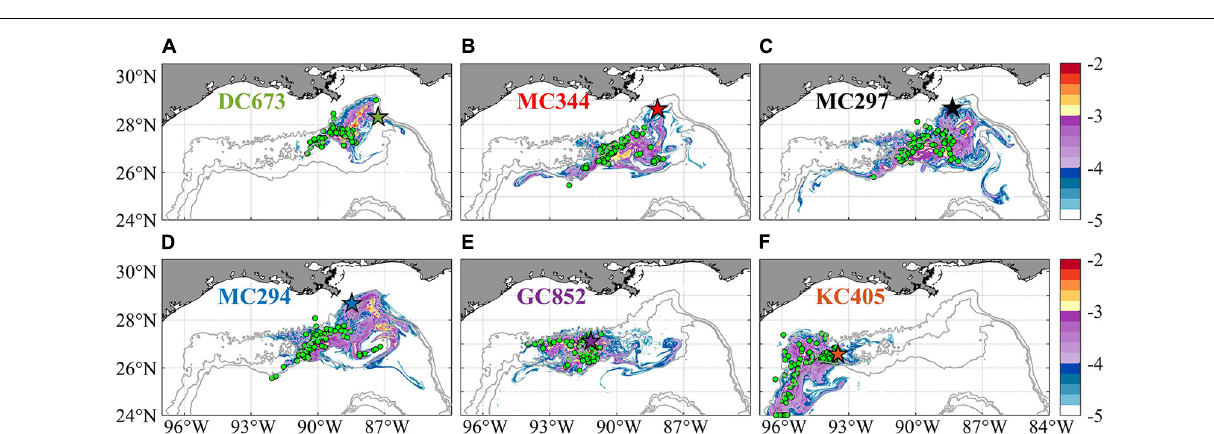
FIGURE 11 | Horizontal distribution of integrated Eulerian dye concentration normalized by initial tracer concentration (log 10 scale, same as Bracco et al., 2018) and Lagrangian larval particles after 120 days from their release on November 1st, 2015 for sampling site at DC673 (A) , MC344 (B) , MC297 (C) , MC294 (D) , GC852 (E) , and KC405 (F) . Colored pentagram with black edge shows release location. Green circles indicate the positions of Lagrangian particles on the same day. Again, particles displaced vertically more than 800 m from the bottom are not included in the calculation to focus on near bottom processes. The number of particles is randomly subsampled for visualization